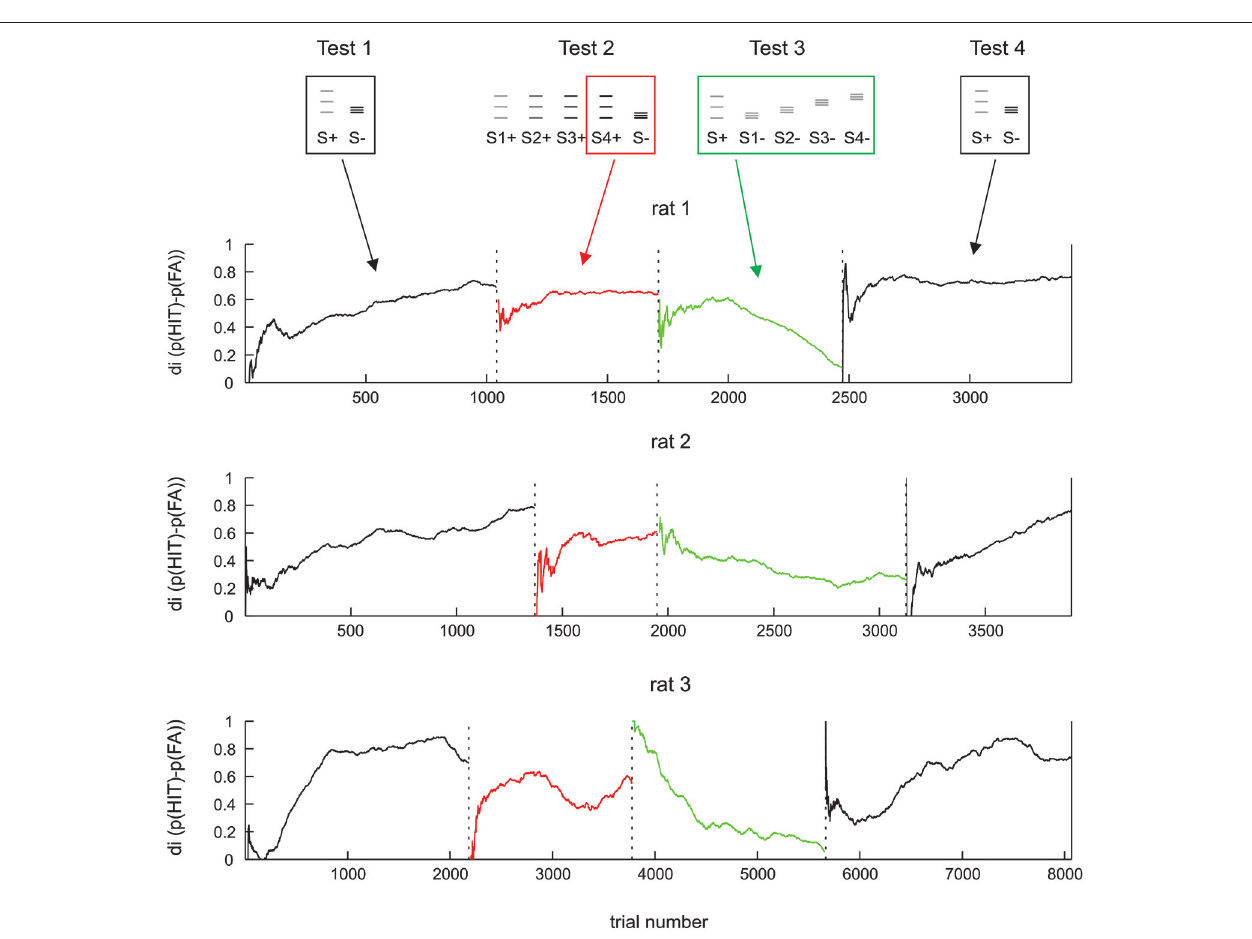
FIGURE 4 | Same data as Figure 3 but shown along trials after boxcar filtering (each Test data was filtered separately; width 500 trials) . For test 2 the discrimination of the amplitude matched pair is shown (boxed icons on top).